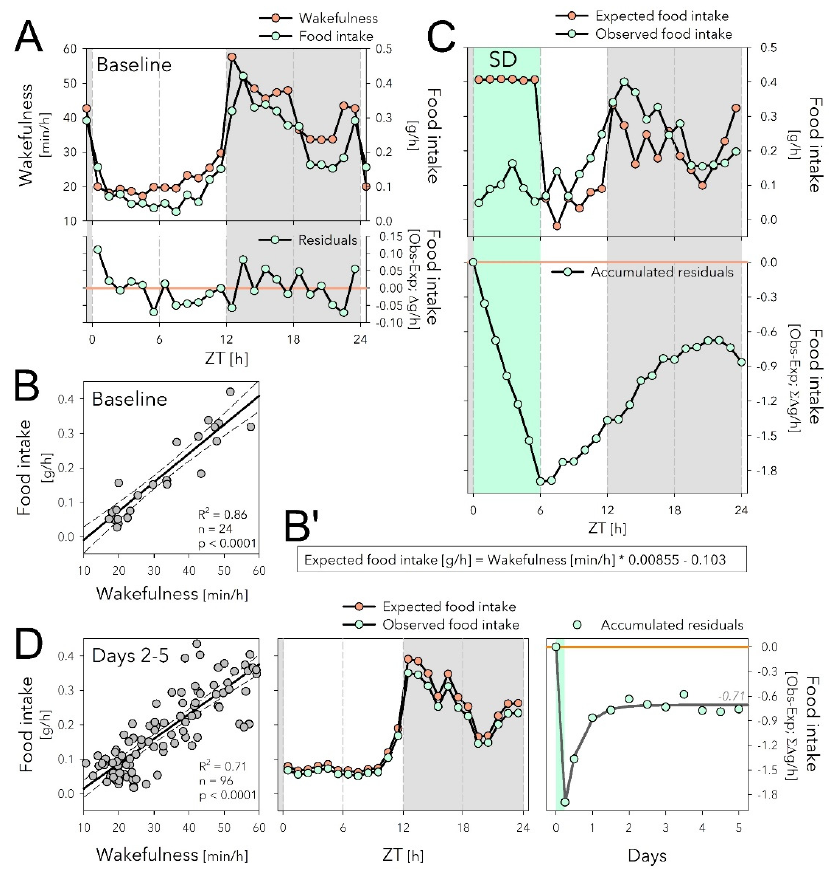
Figure 3. The sleep deprivation (SD) evoked dissociation between food intake and time spent awake might underlie increased food intake during recovery. ( A ) The time course of hourly values of food intake in baseline (mint symbols; mean over Days − 4 to 0; same data as in Figure 2A), closely follows that of time spent awake (orange symbols). ( B ) Mean hourly values of wakefulness and food intake strongly correlated, with only small residuals that did not systematically vary with time of day (lower graph in ( A )). ( B’ ) Equation of the linear regression in panel B used to predict expected food intake in panels ( C , D ) (middle) based on time spent awake. ( C ) Given the equations in B’, the expected food intake can be calculated for Day 1 including the SD (upper graph). SD induced a disassociation between food intake and time spent awake and animals accrued a deficit of 1.89 g of food intake during the SD that reduced to 0.86 g by the end of Day 1 (lower graph). ( D ) During Days 2 to 5 after SD, the relationship between waking and eating was highly correlated as in baseline (left panel, compare with ( B )), and wake-derived expected food intake (given equation ( B’ )) predicted remarkably well the observed data (average over the 4 days, middle panel). The 0.86 g food deficit estimated for Day 1 (see ( C )), was maintained during the following 4 days and stabilized at − 0.71 g (right panel; non-linear regression, exponential saturating function fitted to 12 h values).